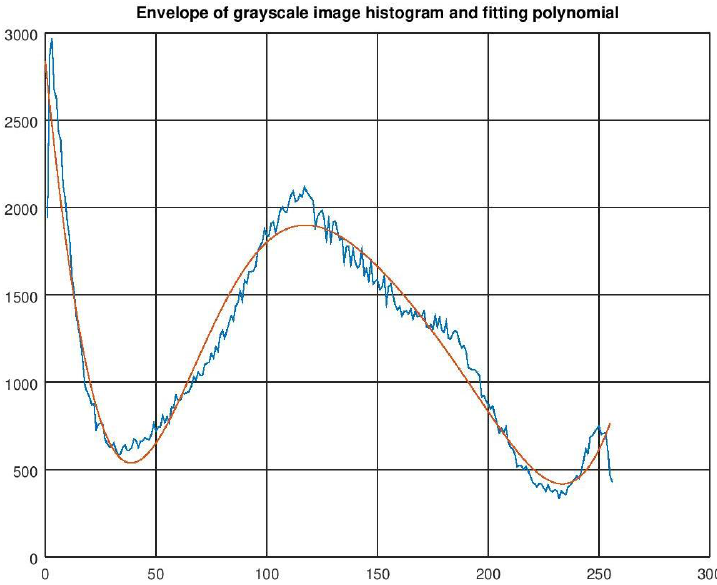
Figure 13. Histogram envelope and fitting polynomial for n =